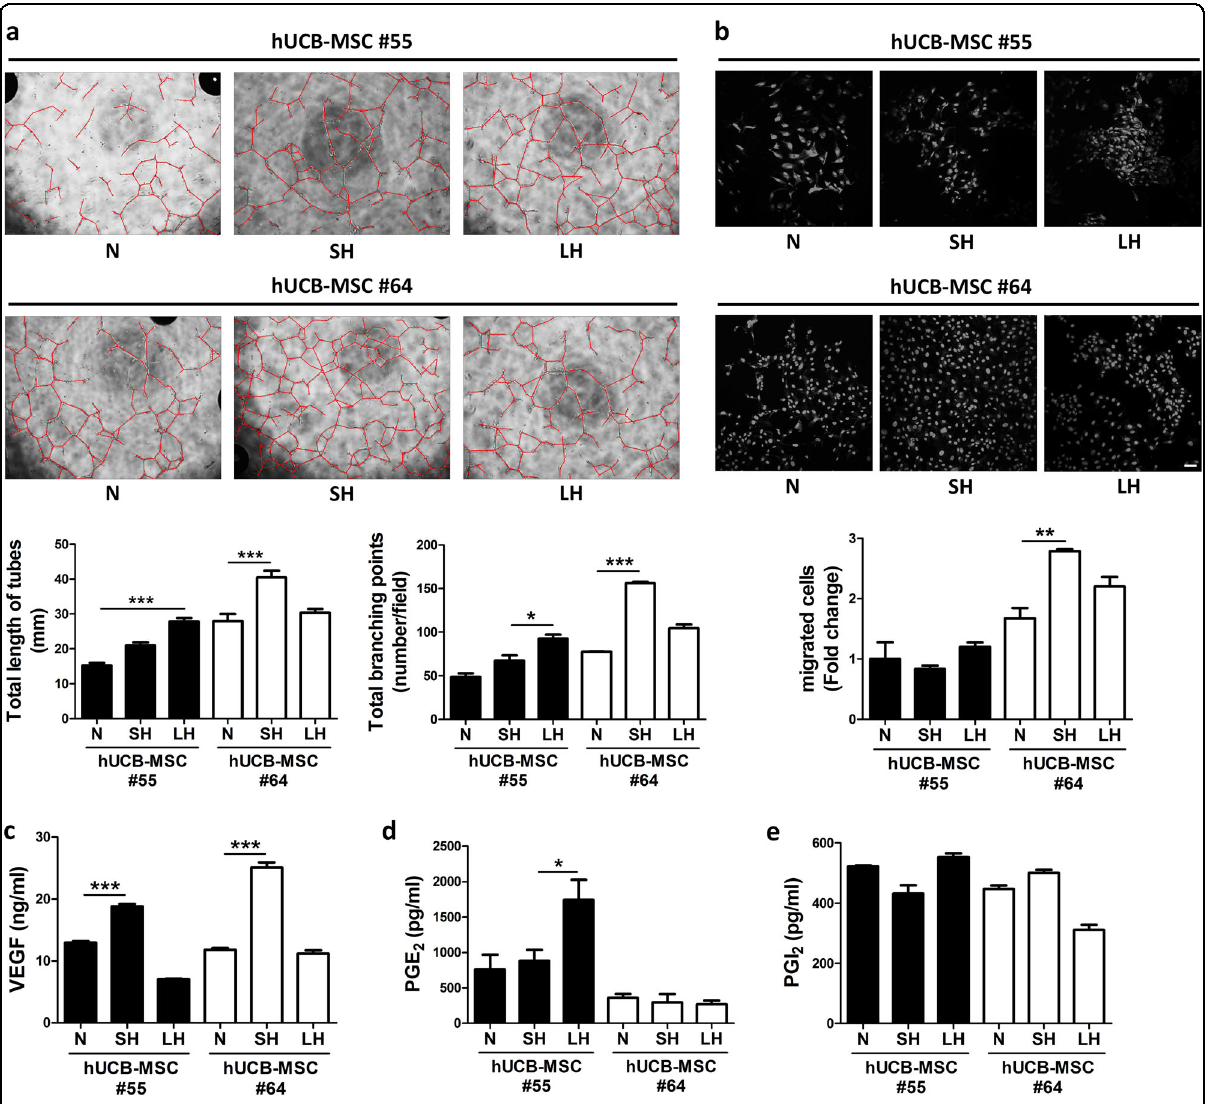
Fig. 5 In vitro angiogenesis capacity is altered between culture condition and donor. a Capillary-like tube formation assay of HUVECs co- cultured with hUCB-MSC #55 or #64. Tube formation was quanti fi ed by total tube formation length and branch junction. Original version of images are shown in Supplementary Figure S3. b Migration assay using HUVECs co-cultured with hUCB-MSCs. Graphs show migrated HUVECs by total cell counting. c – e VEGF, PGE 2 , and PGI 2 concentrations were measured from the cultured media of hUCB-MSCs by ELISA. Scale bars = 50 μ m. * P < 0.05; ** P < 0.01; *** P < 0.001. Results are shown as the mean ±